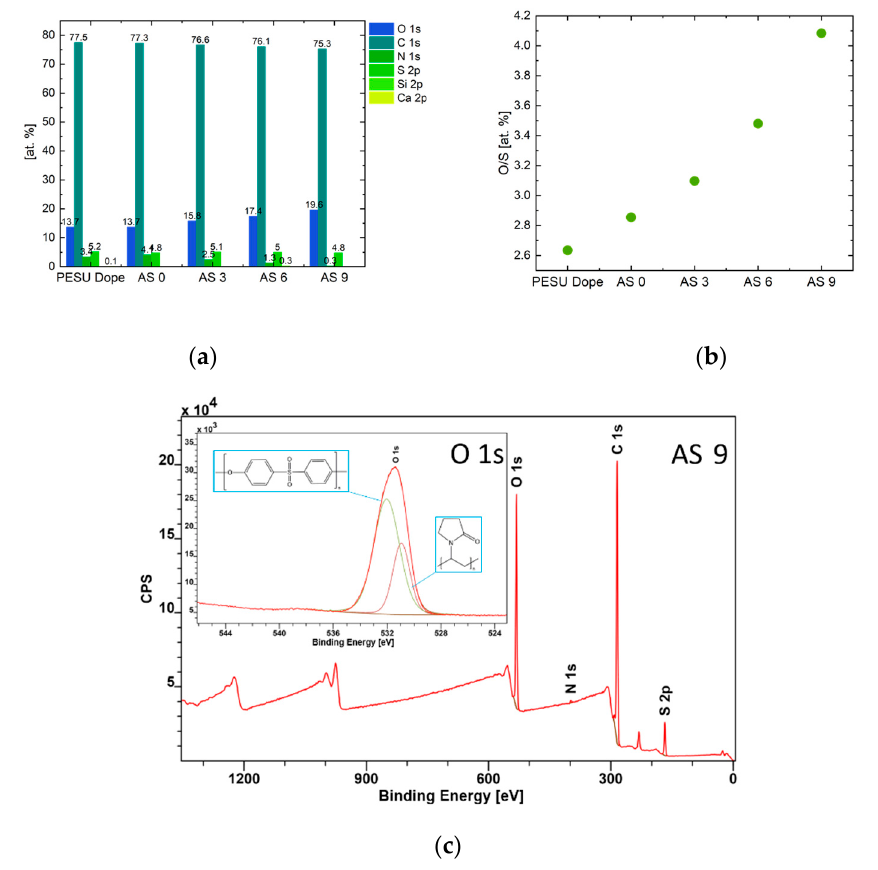
Figure 18. ( a ) Distribution of elements in at% ( b ) Ratio of oxygen to sulfur determined by XPS measurements. An exemplary low resolution XPS survey spectrum of AS 9 is shown in ( c ), while the inset displays the high resolution O 1s